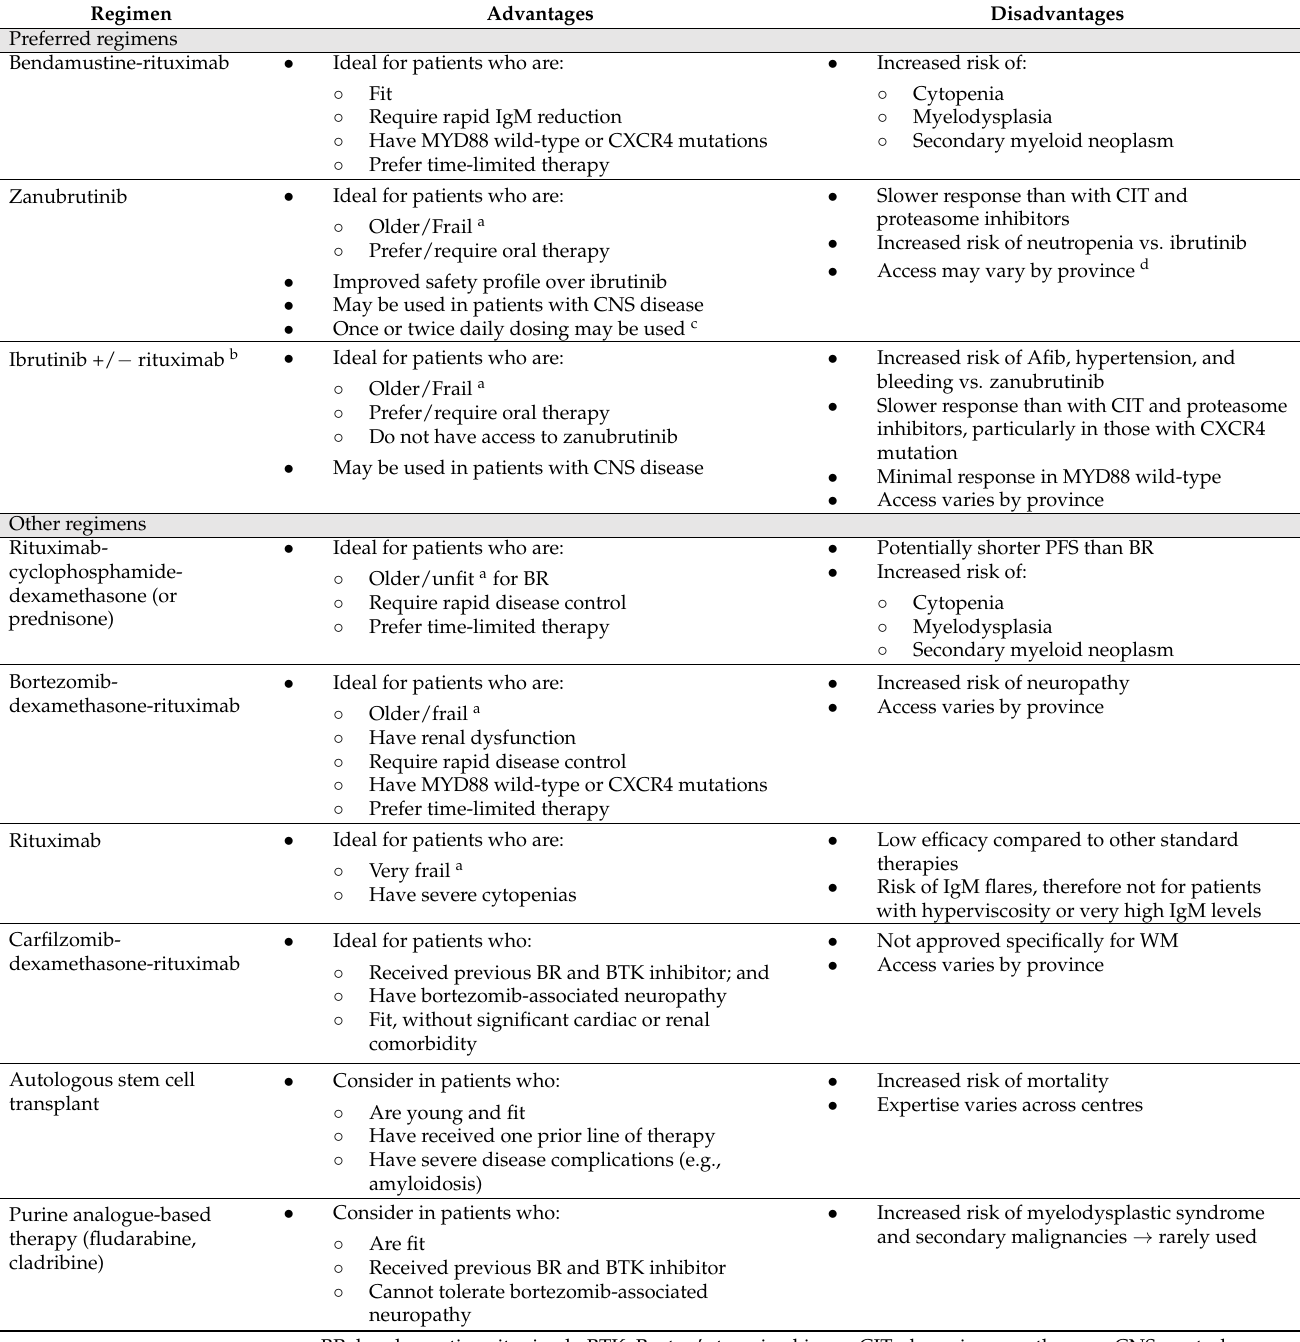
Table 4. Treatment considerations for Waldenström